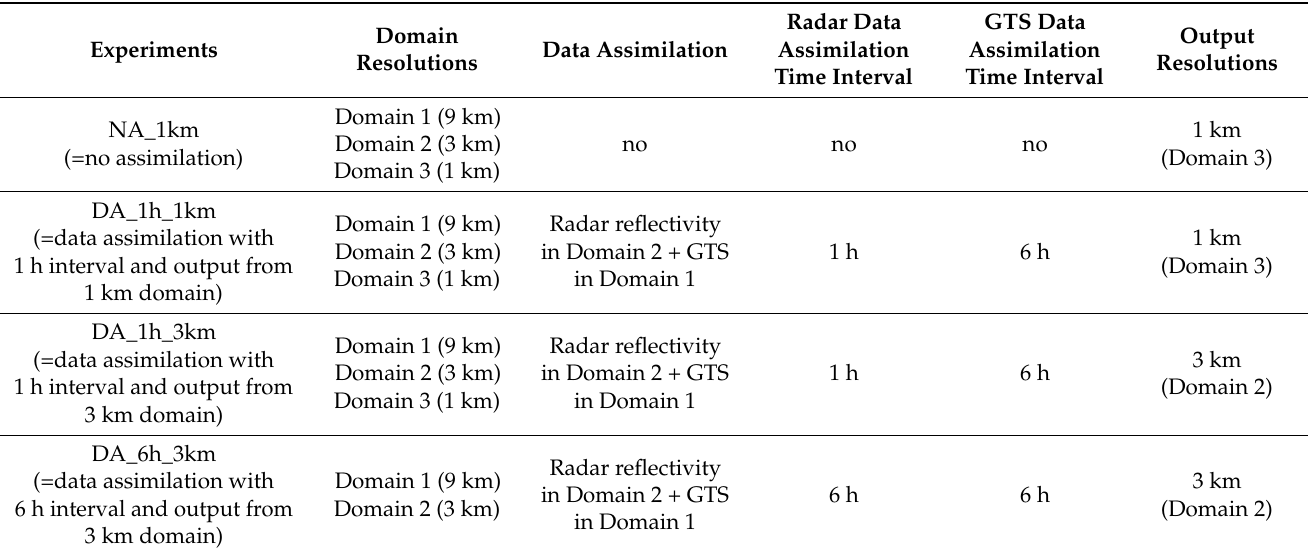
Table 5. Experiment description.